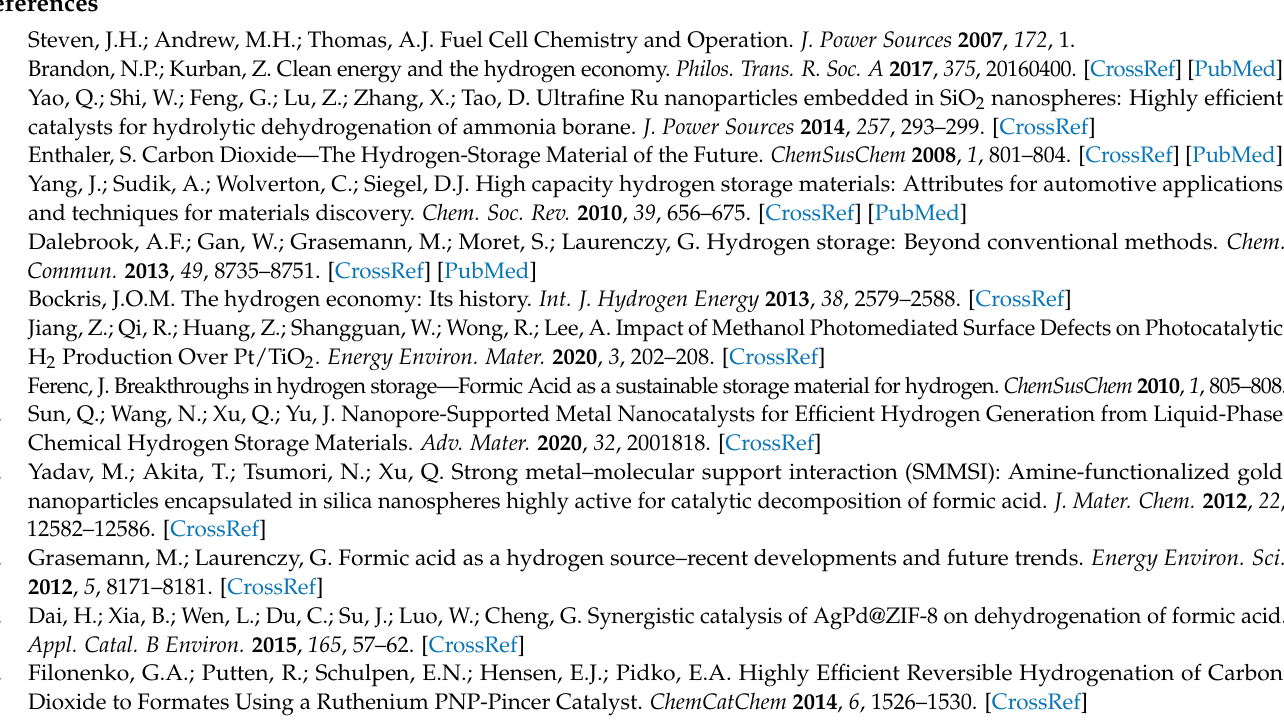
HNTs. Figure S4: GC results of (a) Pd/NH 2 -HNTs and standard sample (b) H 2 , (c) CO and (d) air. Figure S5: The TEM images of spent Pd-NH 2 -HNTs catalysts after the fifth catalytic reaction cycle. Table S2: Turnover frequency (TOF) for different catalysts used for the generation of